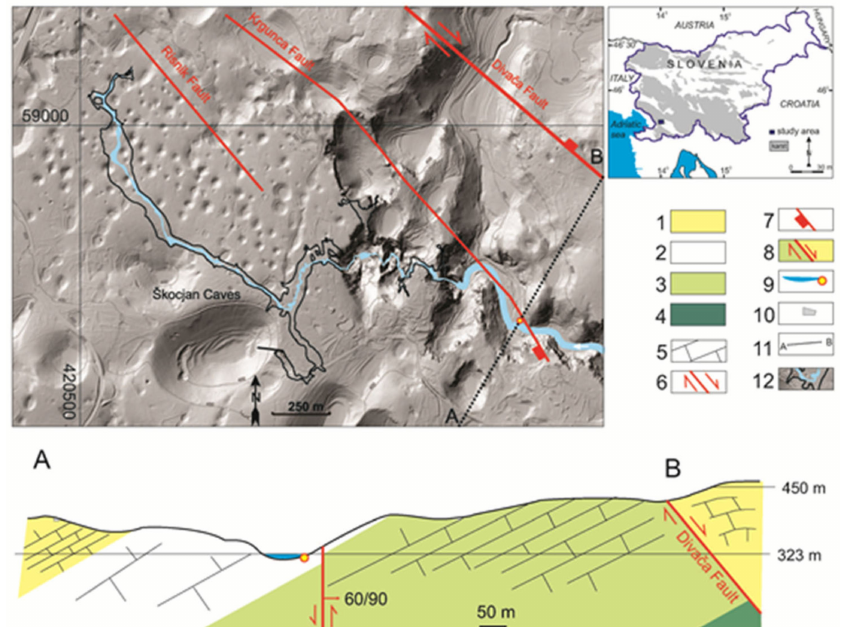
Figure 2. Morphological situation of the Smrdljivec spring and Škocjanske jame with principal faults and geological cross-section A–B. 1—Liburnian Formation (K-Pc) (d = 50–300 m), 2—Lipica Formation (K 24 − 5 ) (d = 250–400 m), 3—Sežana Formation (K 22 − 4 ) (d = 400–500 m), 4—Repen Formation (K 21,2 ) (d < 200 m), 5—Limestone bedding planes in cross-section A–B, 6—Fault with horizontal movement (on ground-plan), 7—Fault with sense of vertical movement (on ground-plan), 8—Fault downthrow and uplift direction in the A–B cross-section, 9—Reka River, with the position of the Smrdljivec spring, 10—road, 11—line of geological cross-section A–B, 12—Škocjanske jame ground plan with the extent of the underground River Reka. LiDAR topography with 50 m contour lines